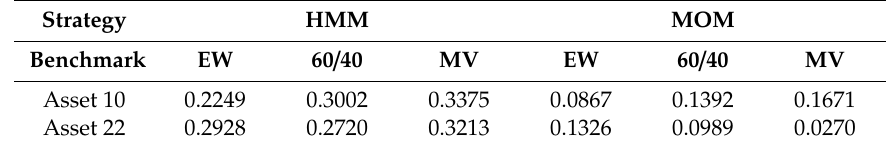
Table 6. Information Ratio